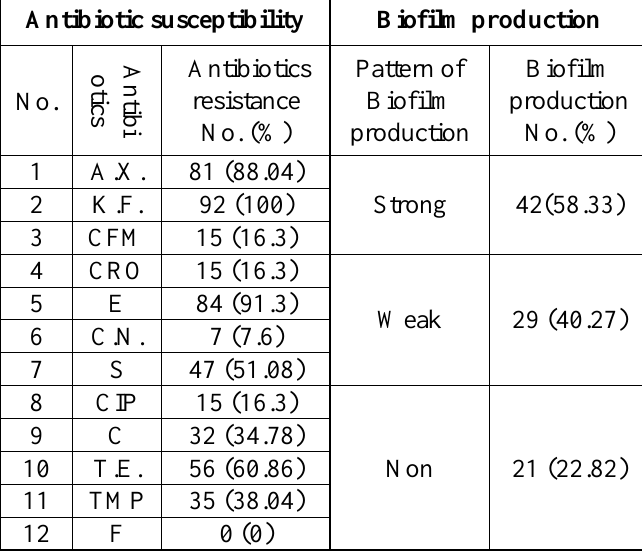
Fig. 1: PCR products of the uidA gene. Lane N, control negative; DNA molecular standard; Lane P, control positive; Lanes 1-5 positive tested samples giving 623bp product size.